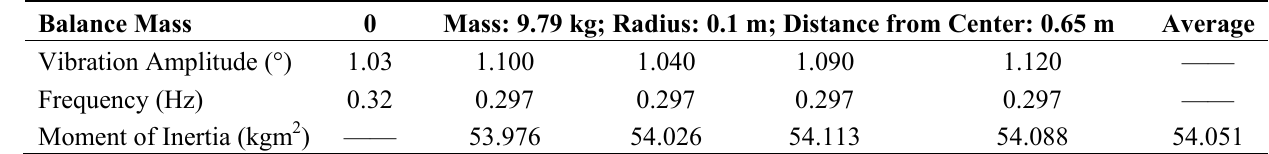
Table 1. Experimental Data of the Moment of